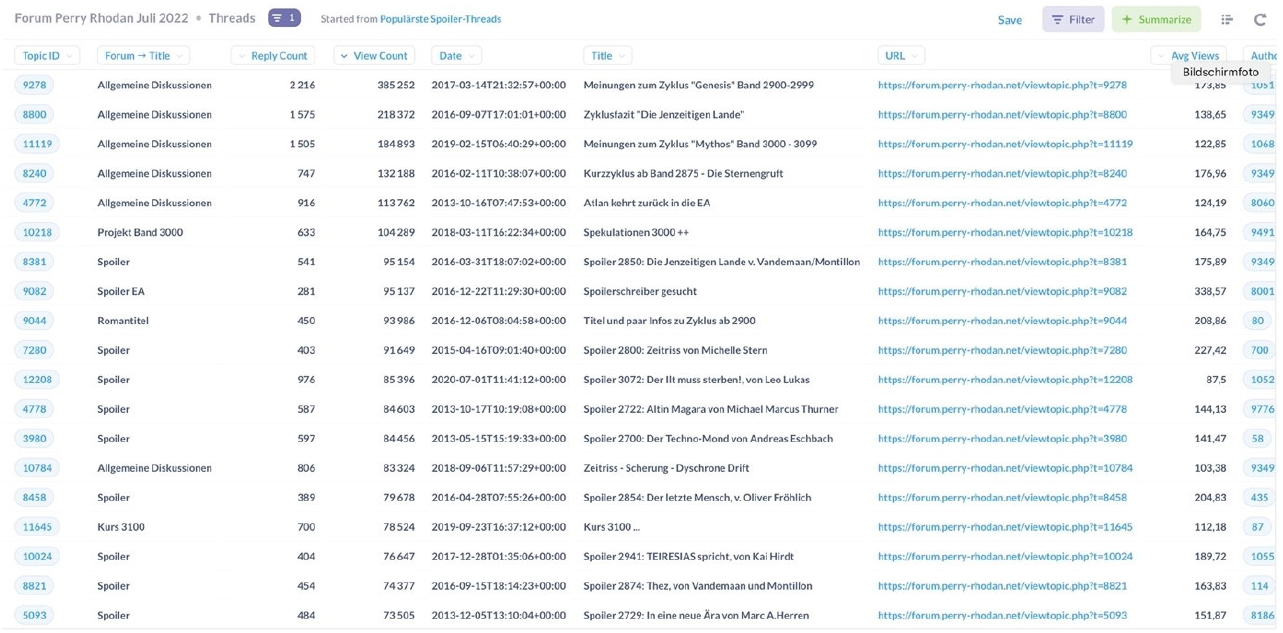
Figure 7. Listing of the most popular forum threads by replies and views. The thread about the Mythos cycle is in 3rd place; the thread about issue #3072 in 11th place.